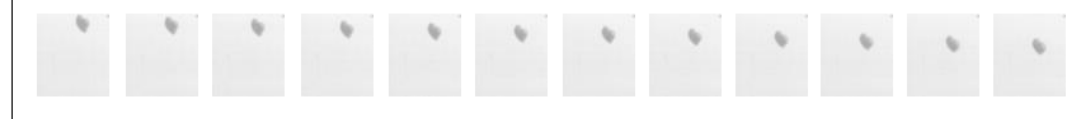
Figure 6. The fi rst 12 successive images of the free-falling aggregate test. Figure 6. The first 12 successive images of the free-falling aggregate